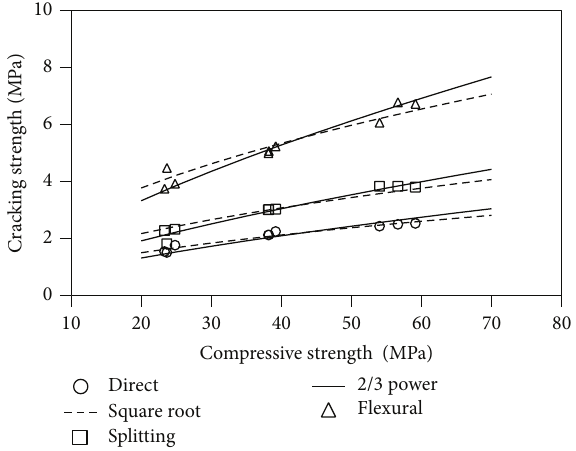
Figure 5: Correlation of various cracking strengths with compres- sive